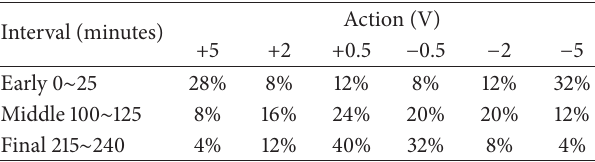
Table 2: The percentage of choosing action in different